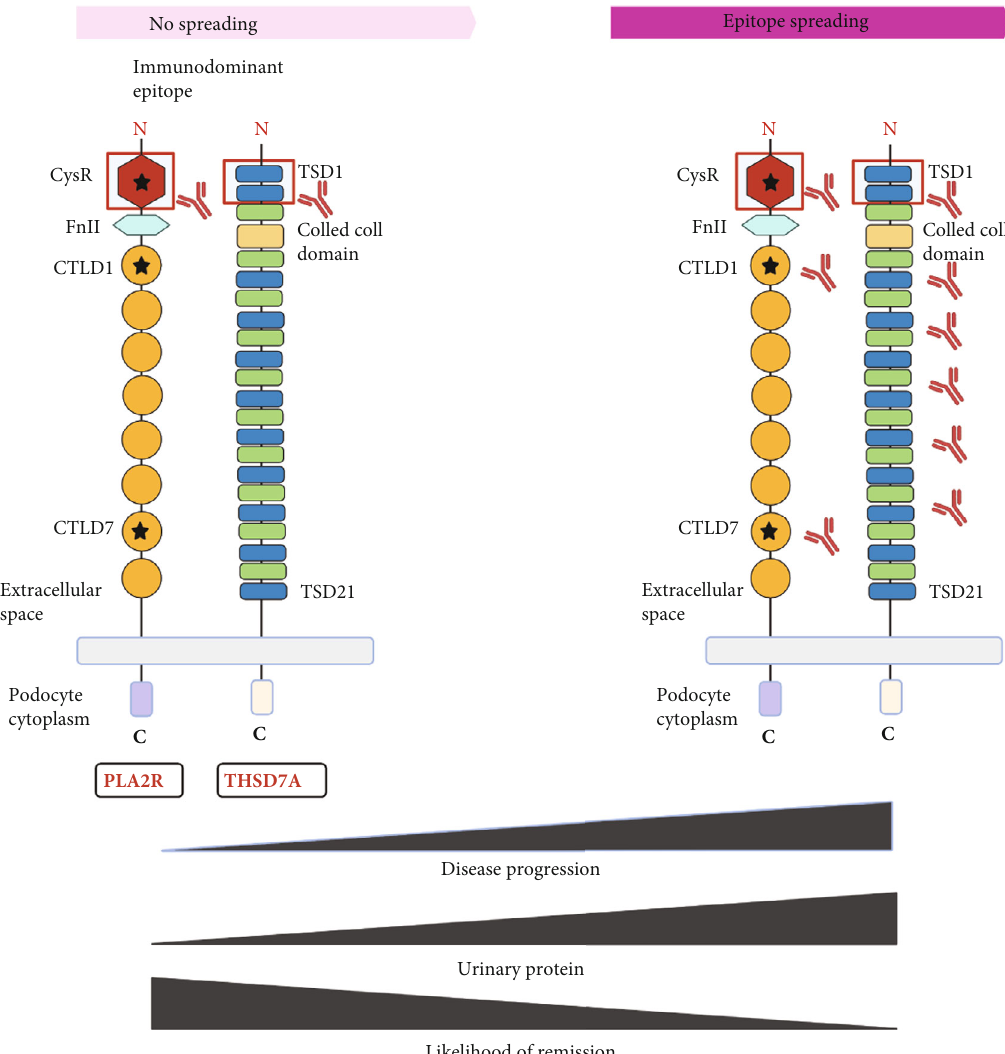
Figure 1: Schematic and epitope spreading of phospholipase A2 receptor (PLA2R) and of thrombospondin type 1 domain-containing 7A (THSD7A). The extracellular part of PLA2R contains an N-terminal cysteine-rich (CysR, or ricin B) domain, a single fi bronectin type 2 (FnII) domain, and eight C-type lectin-like domains (CTLDs). The major epitopes are located in the CysR, CTLD1, and CTLD7 domains. THSD7A is a type 1 transmembrane protein with a large extracellular N-terminal region comprising 21 thrombospondin type 1 domains (TSDs) and a coiled coil domain in the extracellular. The predominant target of autoimmunity in two antigens existed in the N-terminal region. Epitope spreading begins with the outermost epitope of the target antigen, and then, other dominant immune epitopes within the molecule or on neighboring molecules are exposed as the disease progresses, which are accompanied by the increase of proteinuria and the decrease of